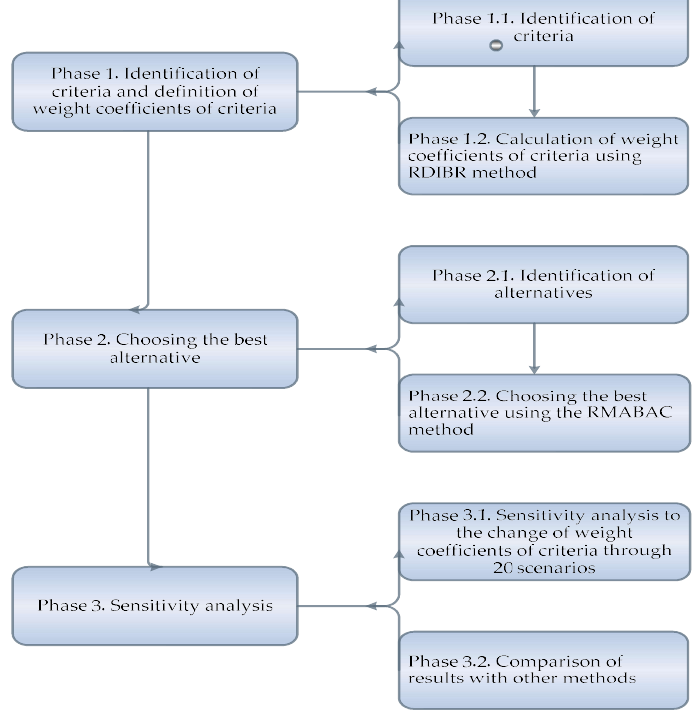
Figure 1. Rough DIBR—Rough MABAC model.